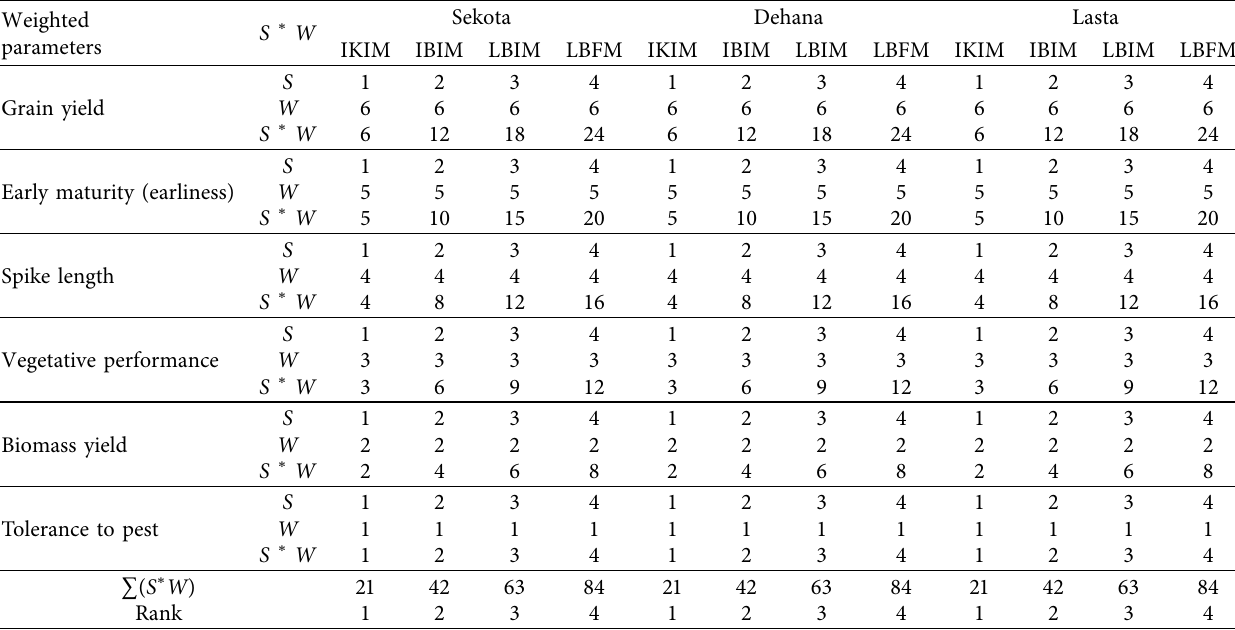
Table 5: Farmers’ preference attributes and ranking matrix results of treatments across